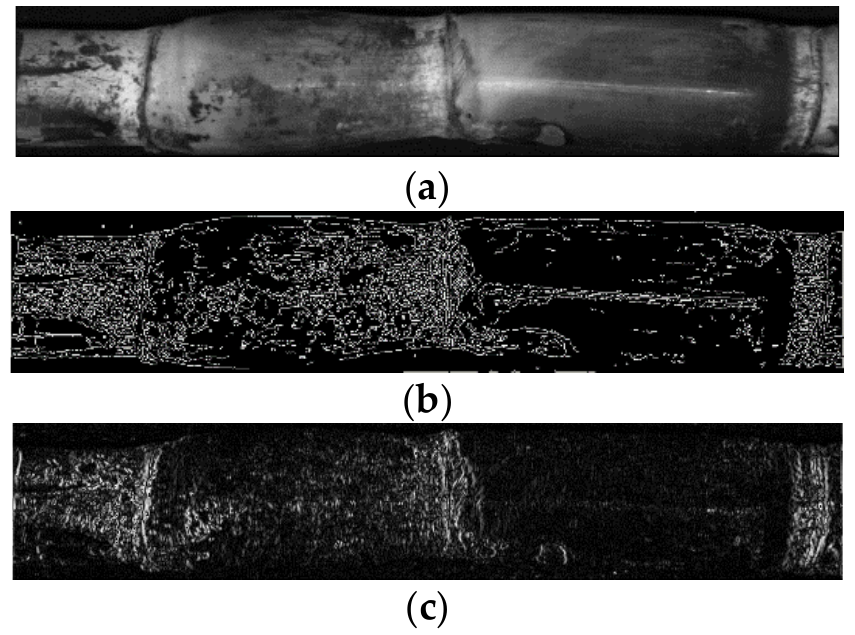
Figure 9. Edge detection results for the sugarcane R component image with different operators: ( a ) sugarcane R component image, ( b ) edge detection result of Canny operator, and ( c ) edge detection result of the new gradient operator.